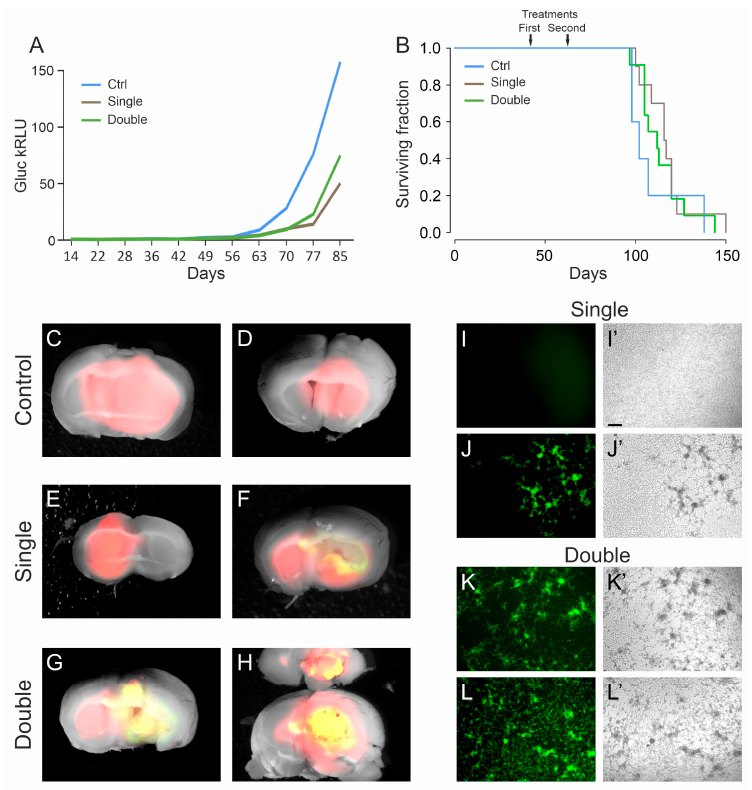
Figure 3. Late treatment with oHSV R-613 on L0306 human glioma cells. ( A ) Median Gluc levels over time for each experimental group measured in blood samples collected starting from 14 days after cell transplant, representing in vivo tumor growth (blue line, control; brown line, single treatment; green line, double treatment). ( B ) Kaplan–Meier survival curves of each experimental arm (same color code as in ( A )). ( C – H ) Merged fluorescence and bright-field micrograph images of two representative brains of mice bearing a DsRed human glioma, for each indicated experimental arm. Yellow areas correspond to DsRed-expressing glioma cells infected by EGFP-expressing R-613. ( I – L ) Fluorescence and ( I’ – L’ ) bright-field microphotographs representing murine glioma cultures expressing human EGFRvIII, inoculated with the filtered supernatant from ex vivo cultured human glioma masses. For each indicated experimental arm, two examples are shown. Scale bars: 25 µm.